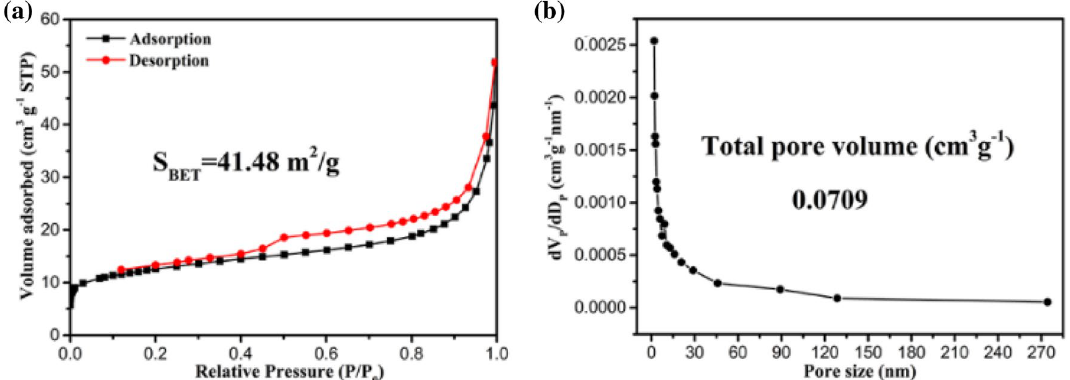
Figure 4. ( a ) Nitrogen adsorption–desorption isotherms and ( b ) pore size distributions of Co/PCNF.